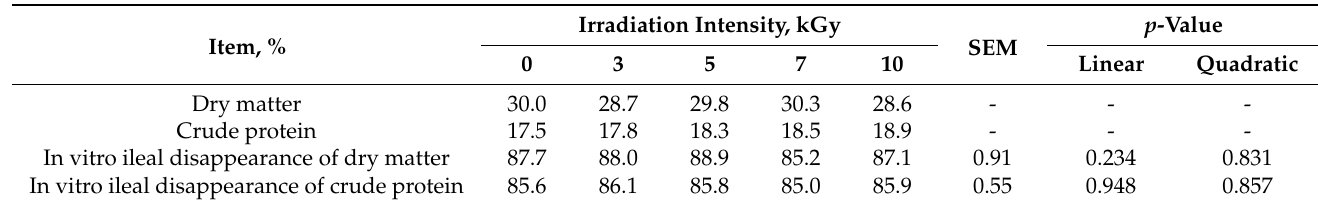
Table 6. Dry matter and crude protein concentrations in electron-beam-irradiated chicken meat (as-is basis) and effects of irradiation intensity on in vitro ileal disappearance of dry matter and crude protein of electron-beam-irradiated chicken meat (Exp. 6) 1 .